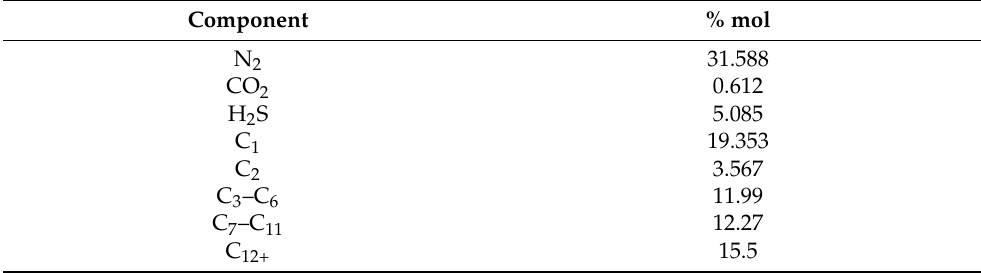
Table 3. Composition of the reservoir fluid after component